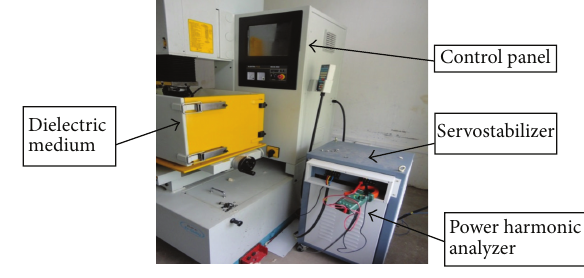
Figure 3: The experimental